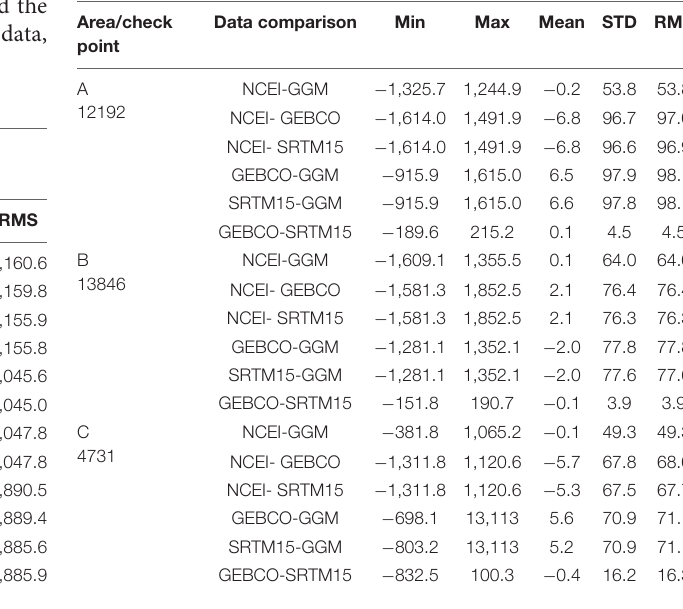
Figure 7 shows the positions of the points where the error is greater than 250 m (black points) at the check points. In Figure 7A , the rectangular I (112.7–116.5 ◦ E, 16–18.5 ◦ N) has poor accuracy. In Figure 7B , rectangular II (111.85– 113.8 ◦ E, 13.2–15 ◦ N) is the area where the error distribution is concentrated. Rectangular III (113.9–116.6 ◦ E, 12.7–15 ◦ N) shows that bathymetry of GGM prediction is poor in the area of chain seamounts and linear seamounts. The complex geological structure with great change lead to more error points in these areas. The error points shown in Figure 7C are relatively dispersed, and its error is relatively small. Based on the geological structures of the SCS (Qiu et al., 2016) and GGM bathymetry result ( Figure 7 ), the shape of